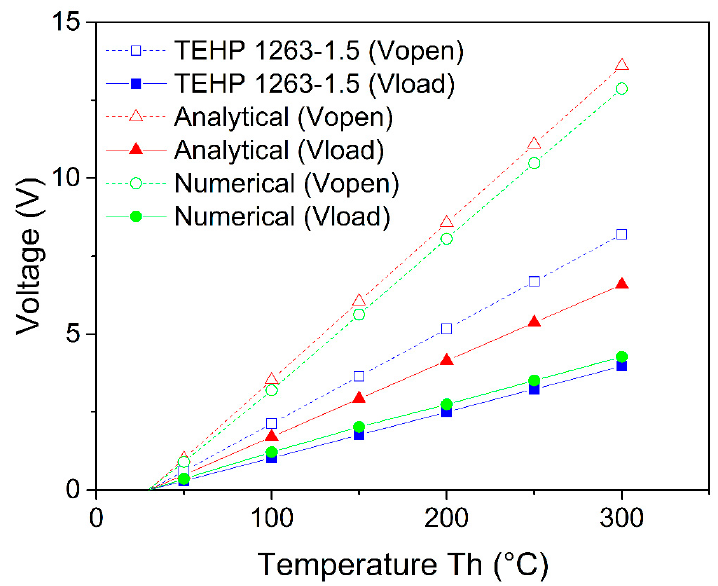
Figure 5. Behavior of the open circuit voltage and charge voltage, varying T h and T c = 30 °C.